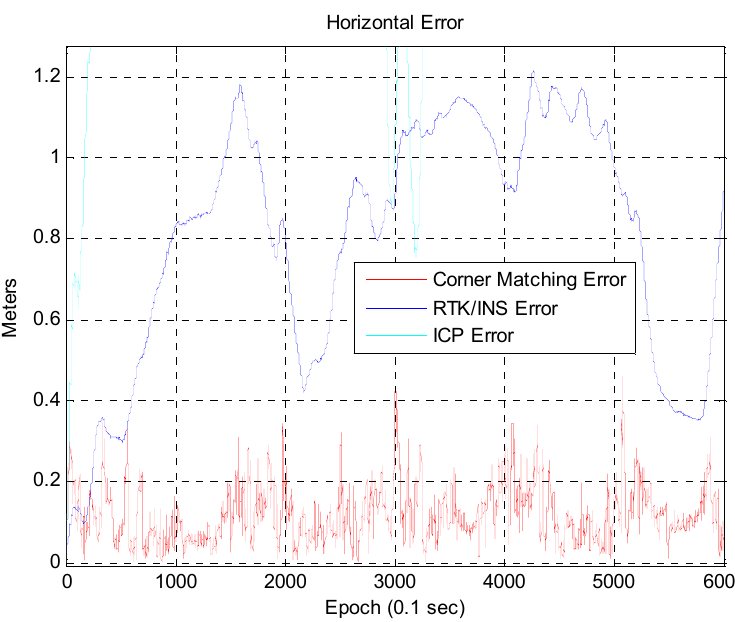
Figure 17. Position error (corner map matching and RTK/INS).